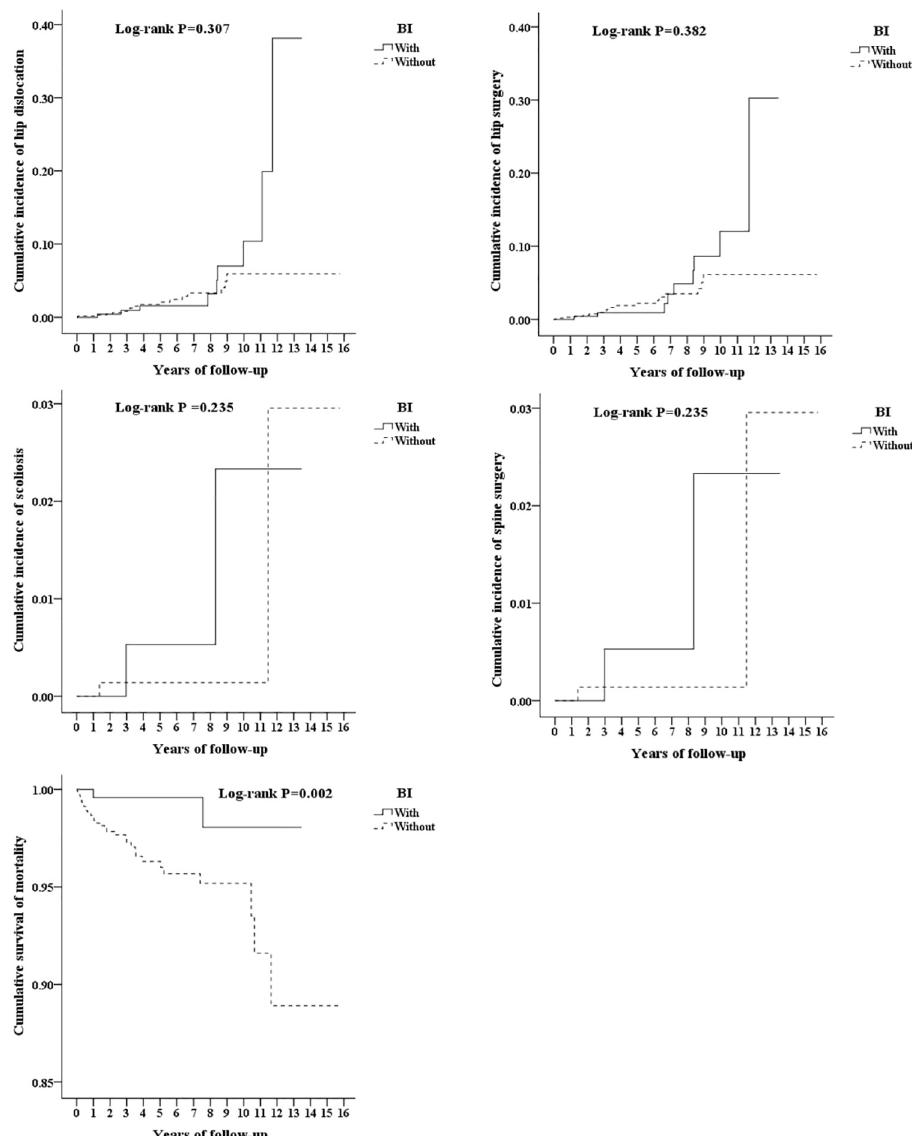
Fig 2. Cumulative incidence of outcomes. Top left: hip dislocation. Top right: hip surgery. Middle left: scoliosis. Middle right: spine surgery. Bottom left: cumulative survival of mortality.